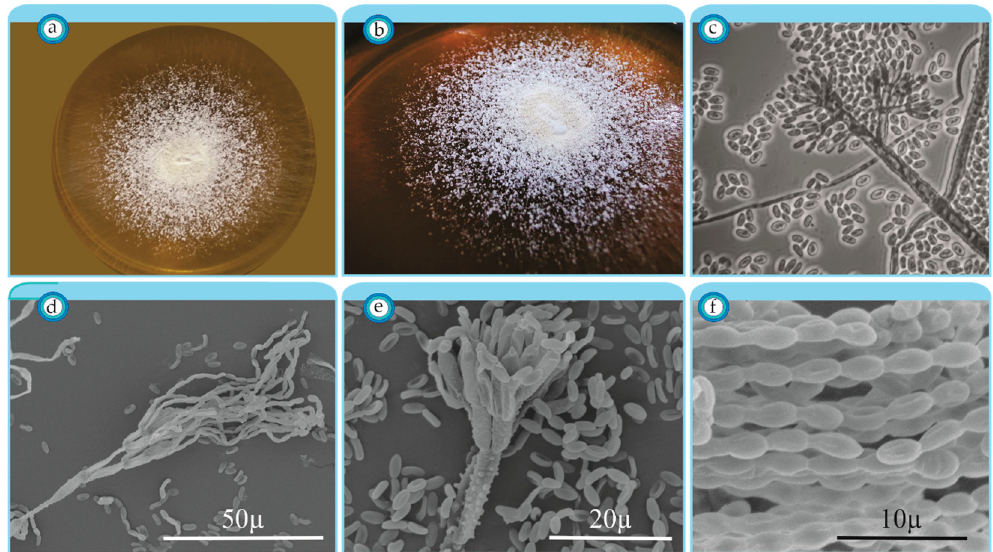
Figure 7. Colonies and microscopy characteristics of strains obtained from J. flaccida - P. deleoni and clustered with Geosmithia sp. 21- G. xerotolerans clade. ( a , b ) Colonial morphology in MEA; ( c ) conidia at 14 days of incubation in MEA using blue cotton in phases microscopy (40 × ); ( d – f ) electronic microscopy of penicilli and conidia.